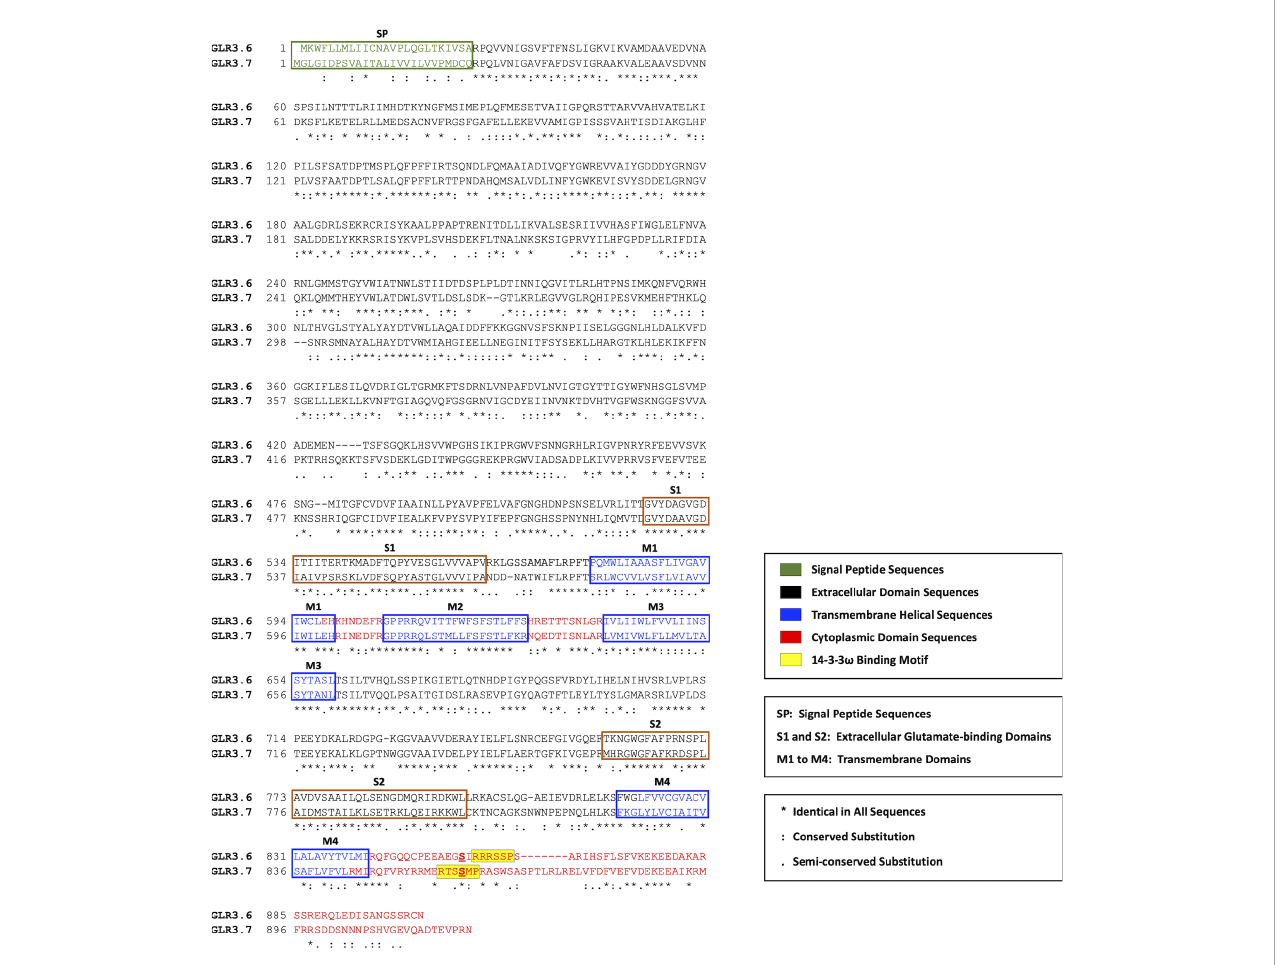
FIGURE 1 Sequences alignment of GLR3.6 and GLR3.7. The plasma membrane localization signal peptide (SP; green coded), extracellular domain (black coded), transmembrane helix (purple coded), and cytoplasmic domain (red coded) are shown. The extracellular glutamate binding domains (S1 and S2) and four transmembrane domains (M1 to M4) are indicated; M2, an ion-pore loop does not span the membrane. The sequences and protein structures of GLR3.6 and GLR3.7 are similar (45.2% identity). The 14-3-3 w -binding motif is highlighted in yellow shading. Consensus symbols of (*) identical, (:) conserved, and (.) semi-conserved residues are as indicated. Amino acid sequences were aligned with the use of ClustalW